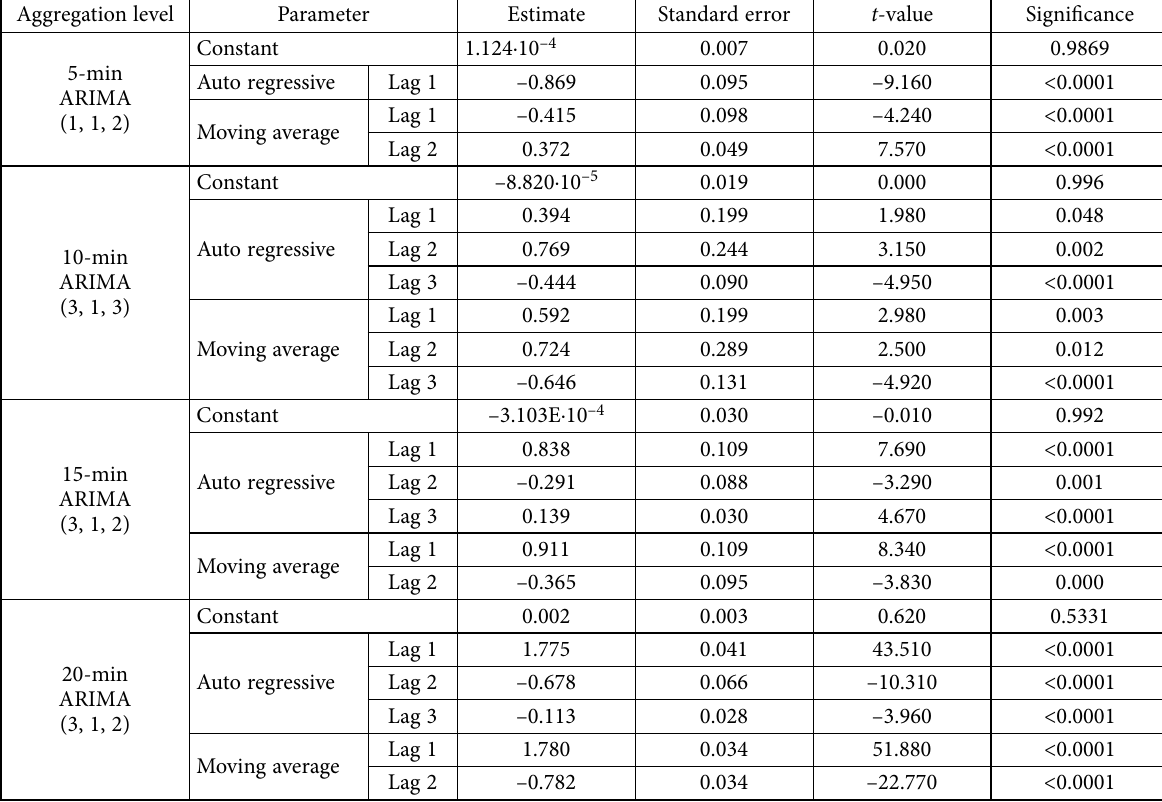
Table 5. Estimation results of the ARIMA models for different aggregation intervals at Site